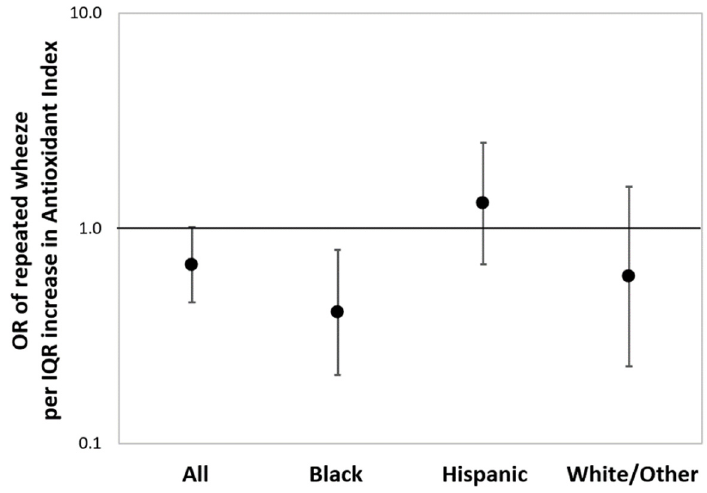
Figure 2. Associations between maternal antioxidant index (AI) score and children’s repeated wheeze. Results from multivariable-adjusted logistic regressions examining associations between maternal AI score and children’s repeated wheeze in the sample overall and stratified by race/ethnicity (Black: Black/Hispanic Black; Hispanic: non-Blank Hispanic; White/Other: non-Hispanic White/other race). Solid dot denotes odds ratio (OR) of repeated wheeze per interquartile range (IQR) increase in AI score, and the error bars denote 95% confidence interval (95% CI). The models were adjusted for child sex, maternal age at delivery, education status, maternal history of asthma (and race/ethnicity in the overall model). IQR of antioxidant index: 39.3 (percentile).